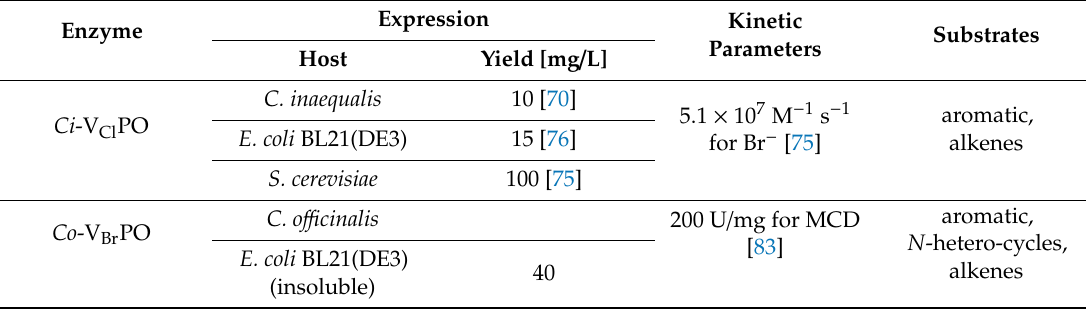
Table 2. Enzymological properties of vanadium-dependent haloperoxidases.